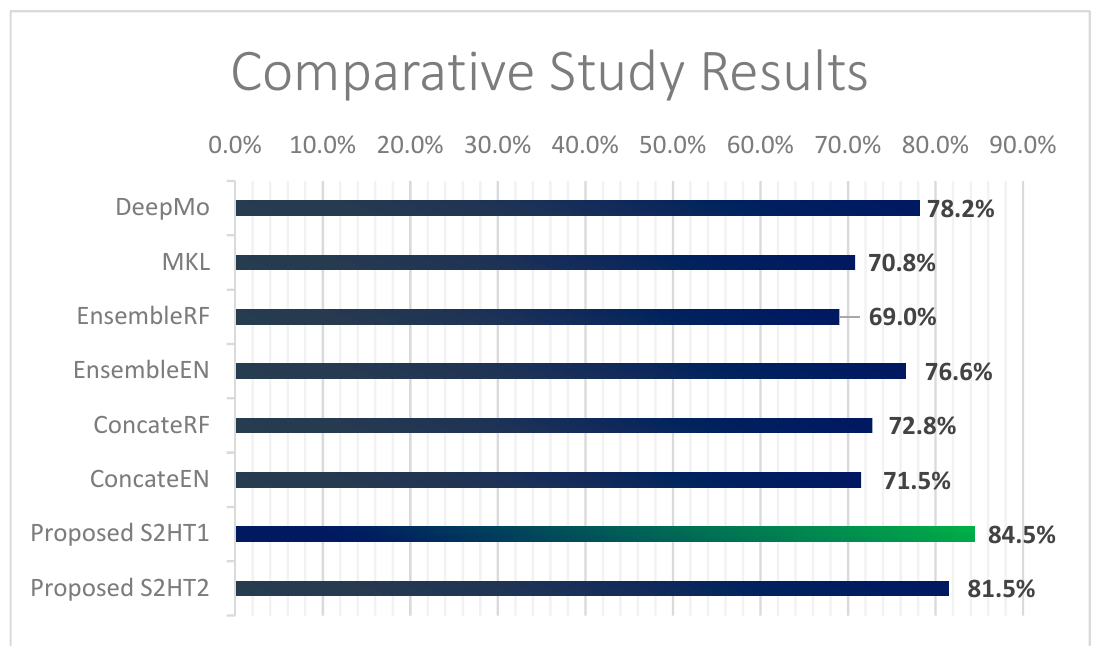
Figure 7. Comparative study results.